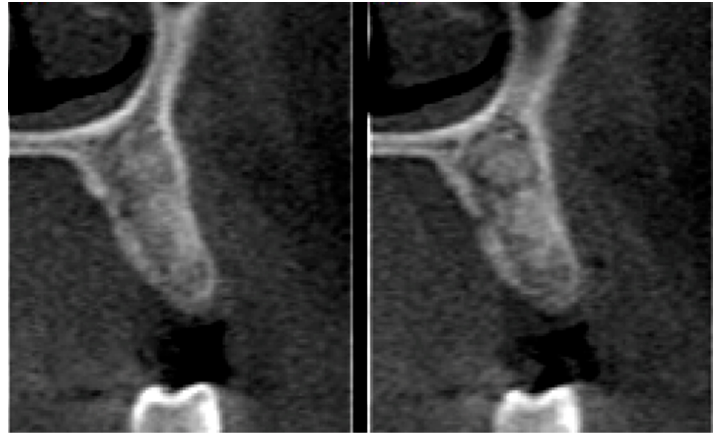
Figure 12. CT images of tooth 14 (TG1) 4 months after the procedure.